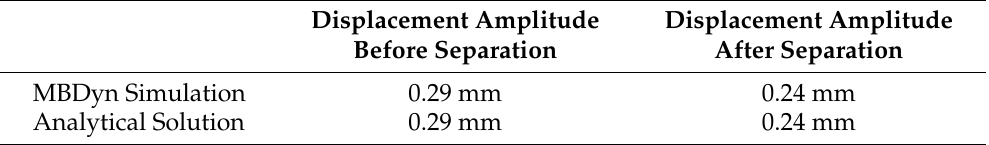
Table 2. Comparison of the steady displacement response that was obtained using multibody solution and the analytical